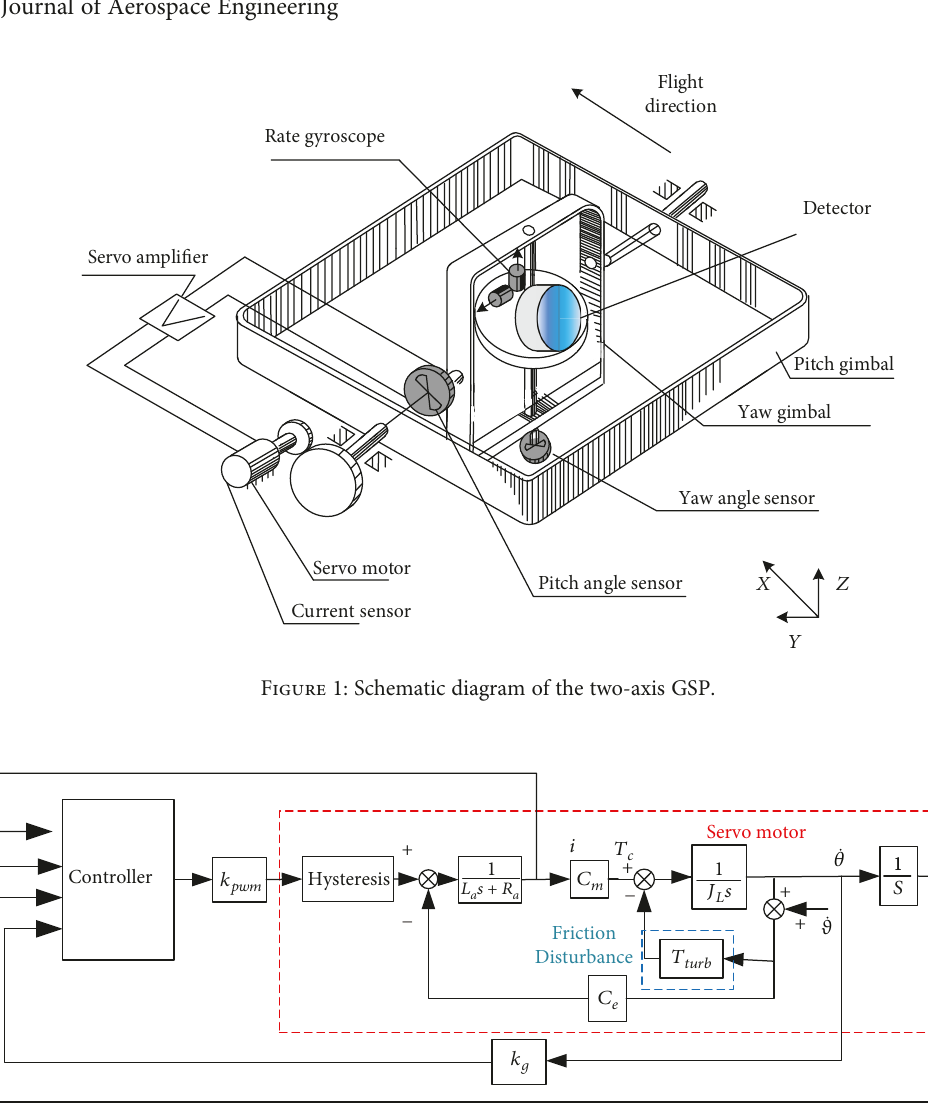
Figure 2: Block diagram of GSP tracking